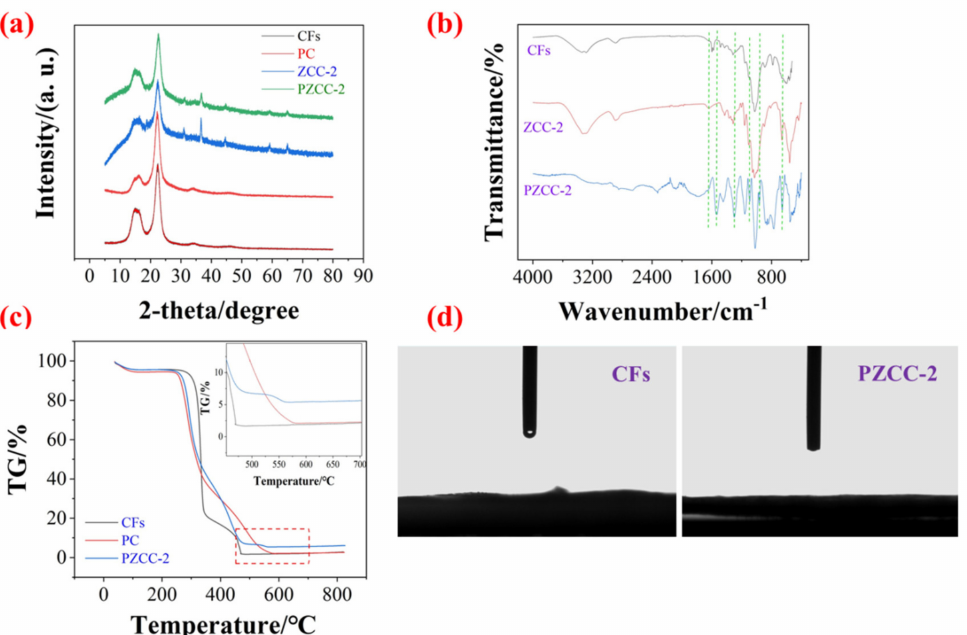
Figure 3. ( a ) XRD patterns of CFs, PC, ZCC-2, and PZCC-2. ( b ) FTIR spectra of CFs, ZCC-2, and PZCC-2. ( c ) TG curves of CFs, PC, and PZCC-2. ( d ) Hydrophilicity of CFs and PZCC-2.